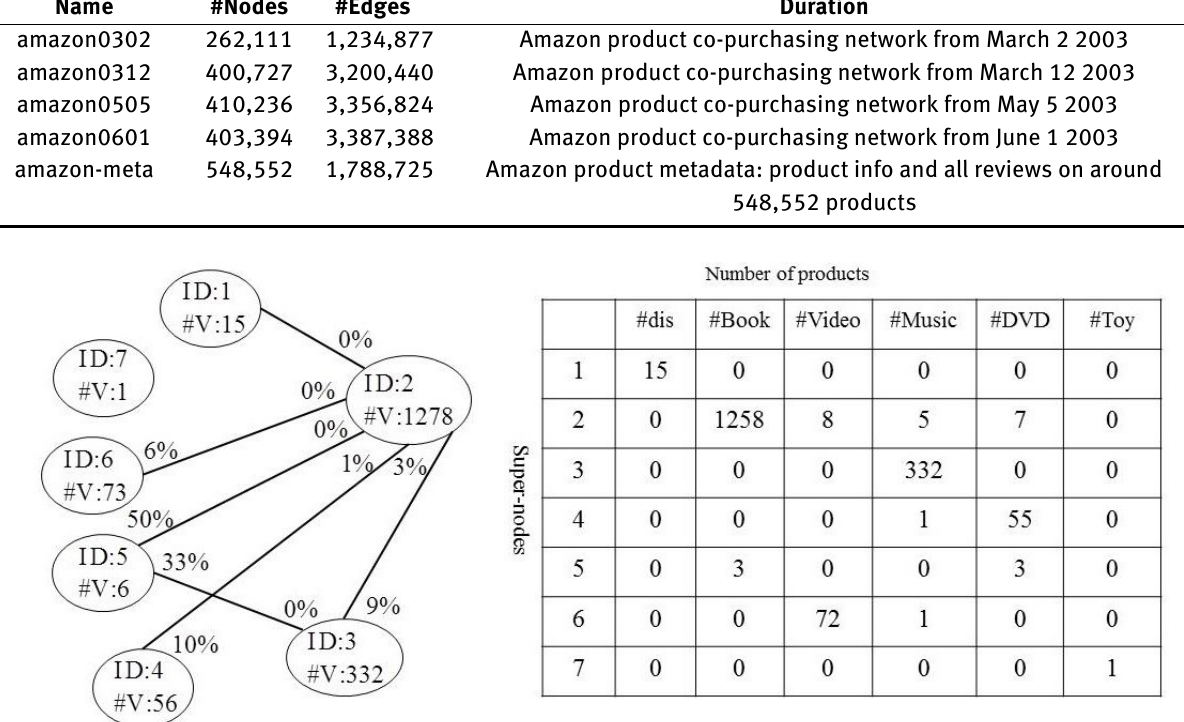
Figure 5: The first summary graph of the size of